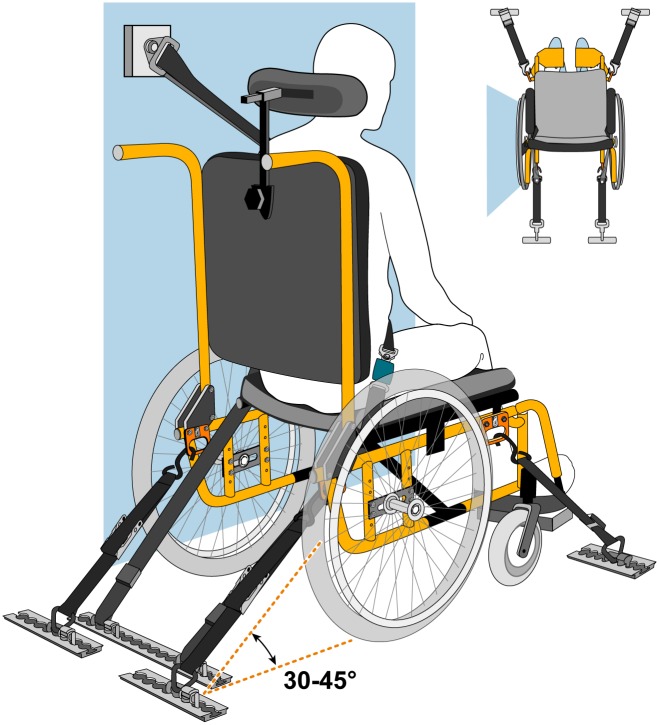
Wheelchair tiedown and occupant restraint system (WTORS).WTORS consisting of two tiedowns securing the front of the wheelchair, two tiedowns securing the rear of the wheelchair, and including both a lap and shoulder belt for occupant restraint (color figure available online).